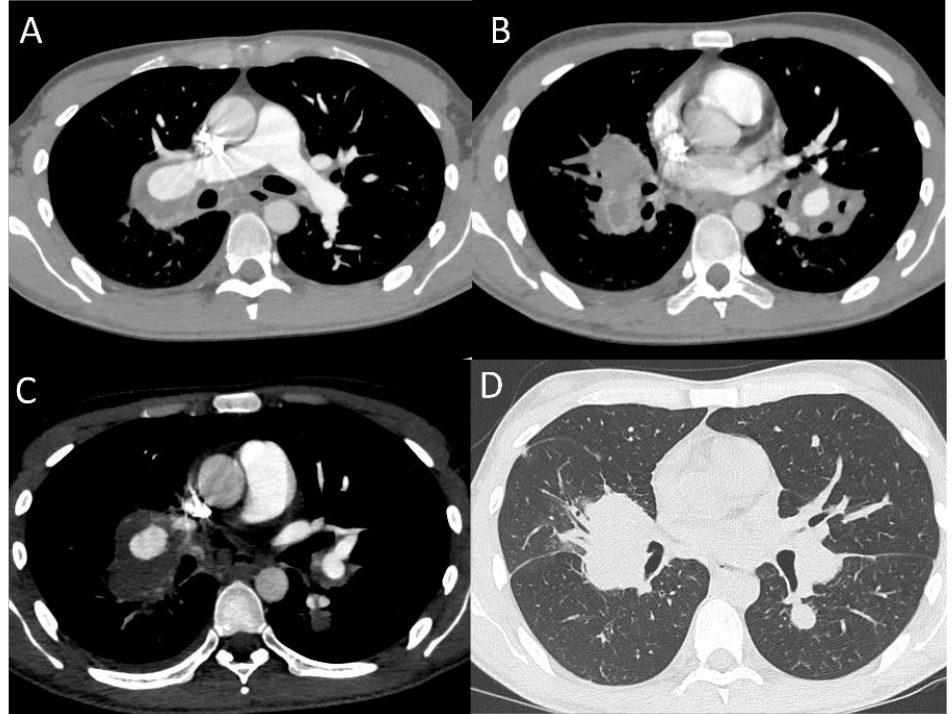
Figure 3. PAAs in BD patient: ( A ) Aneurysm of the middle lobar branch of the right pulmonary artery; ( B , C ) aneurysm of lower lobar branch of both pulmonary arteries; ( D ) parenchymal ground glass opacities beside the aneurysmatic artery branch.